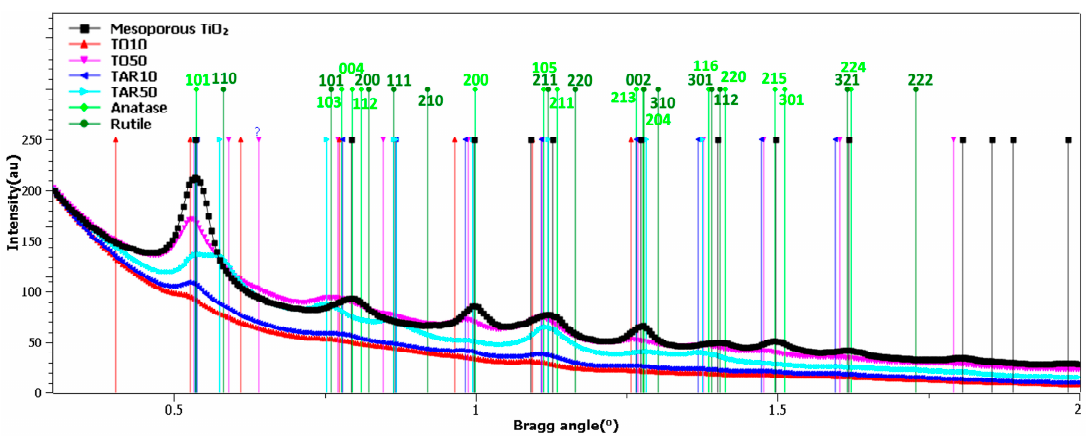
Figure 5. SAED profile obtained using CRISP2 software [59] with the ELD module [60] for the mesoporous TiO 2 film and the buffer layers: TO10, TO50, TAR10 and TAR50. The indexing of anatase and rutile phases, which was performed according to Refs. [61,62], is represented as: Anatase = diamonds and rutile = circles.